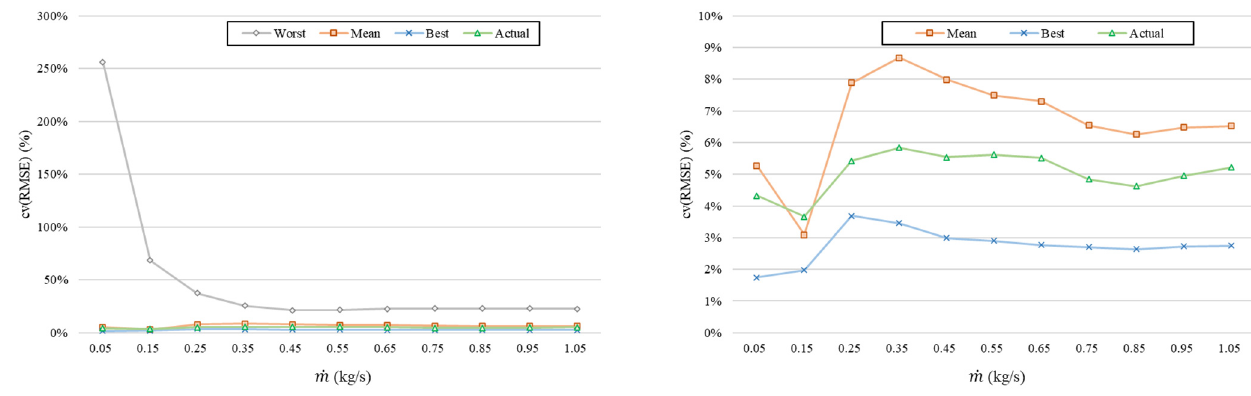
Figure 11. The cv(RMSE) according to the heating mass flow rate